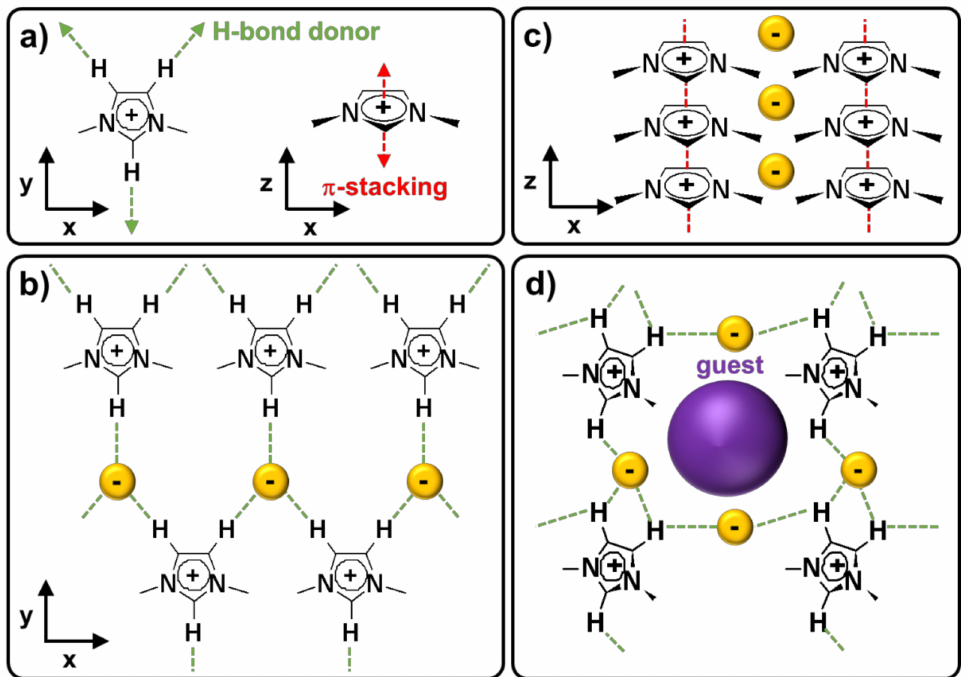
Figure 38. ( a ) H-bond donors (green) and π -stacking (red) of an imidazolium ring; ( b , c ) simplified two-dimensional (2-D) and three-dimensional (3-D) organization of the imidazolium salt; ( d ) the local assembly of the imidazolium ILs around guest molecules.